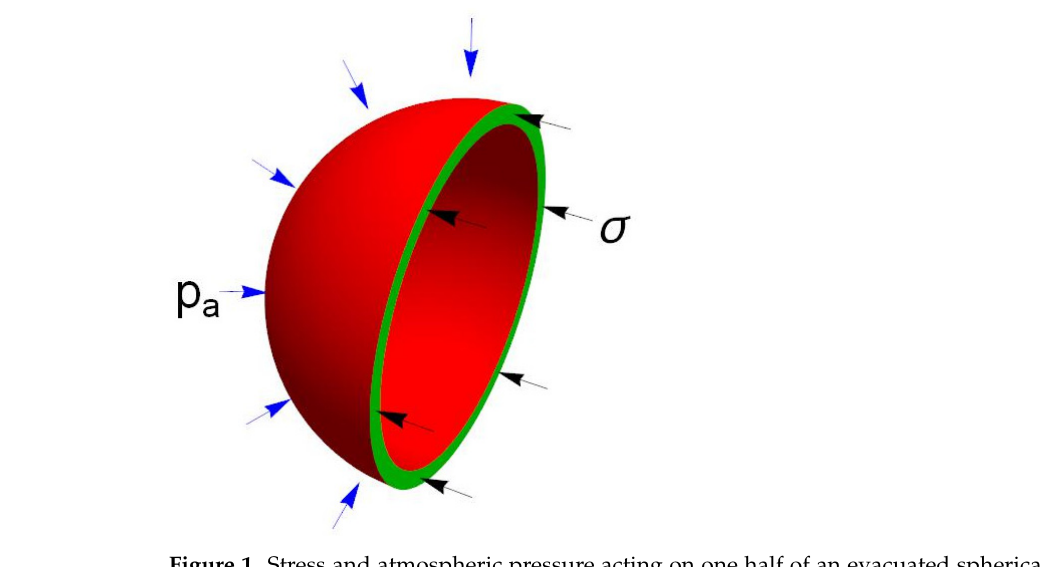
Figure 1. Stress and atmospheric pressure acting on one half of an evacuated spherical shell (not to scale).